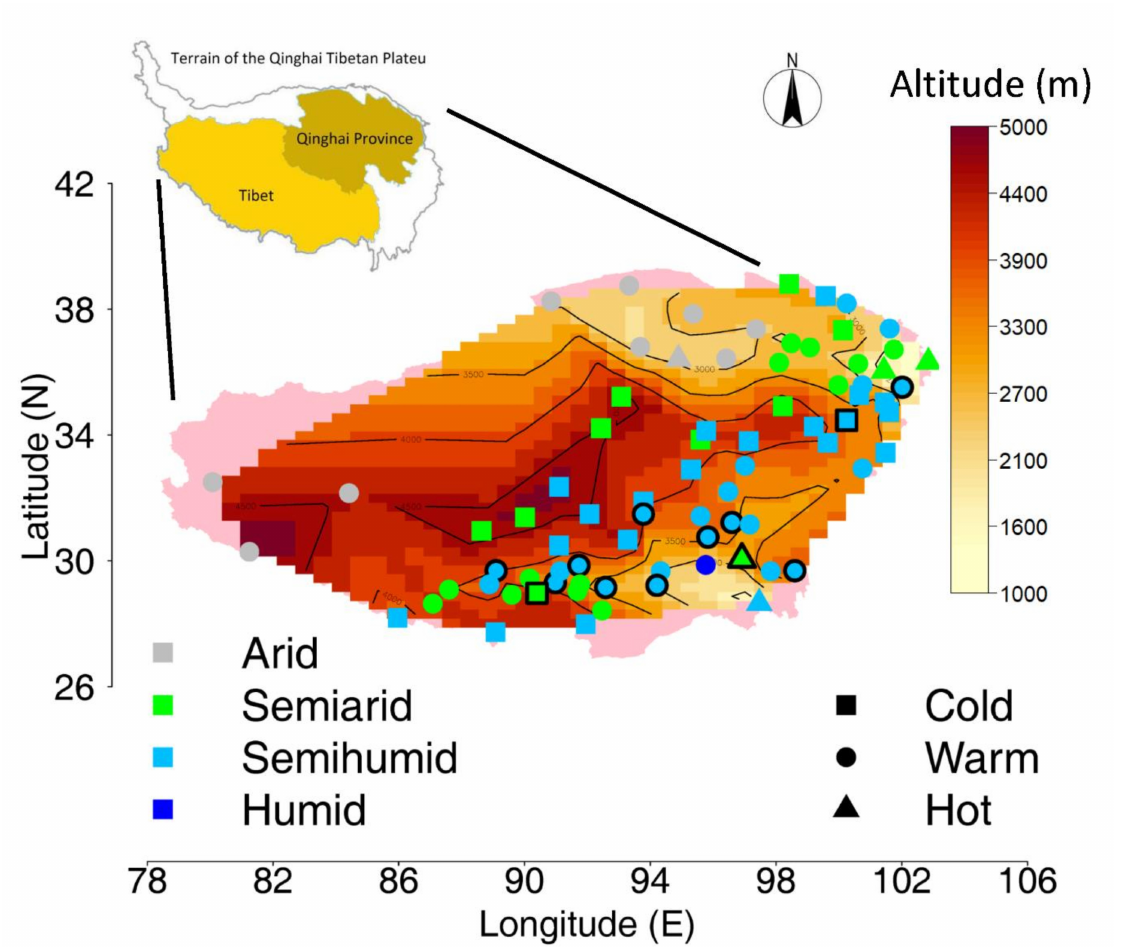
Figure 1. Locations, climate zones and altitudes of 78 weather stations on the Qinghai-Tibetan Plateau. The 13 weather stations established after the 1990s are marked with black borders. Table 1. Location and altitude of each weather station and their corresponding climatic zones. Missing ratio of time series data was calculated separately for precipitation and